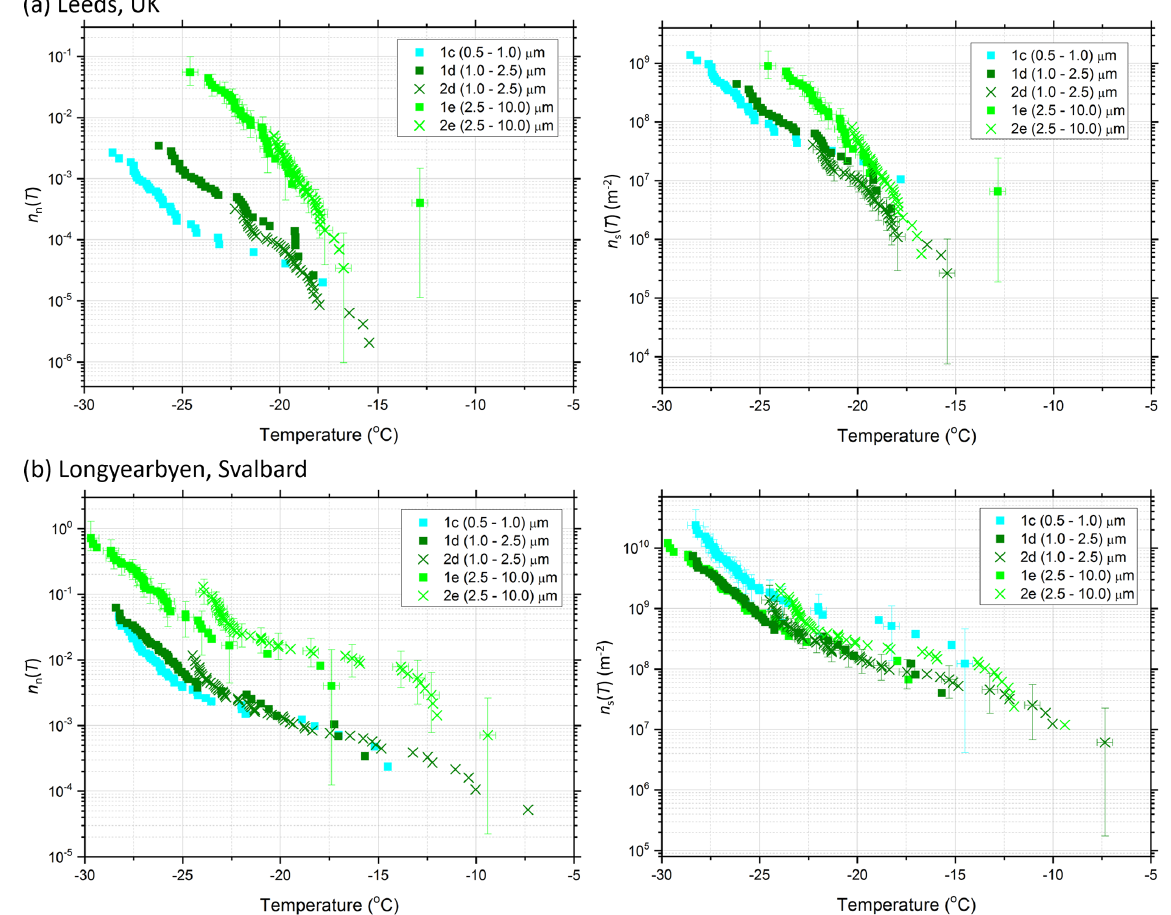
Figure 10. Plots showing (left) the activated fraction of aerosol, n n (T ) , and (right) the number of active sites per surface area, n s (T ) , for samples tested from two measurement sites: (a) Leeds (UK) and (b) Longyearbyen (Svalbard). The colours of the data points indicate the size bins of each impactor, and the different symbols represent the two impactors. Samples of the error bars are